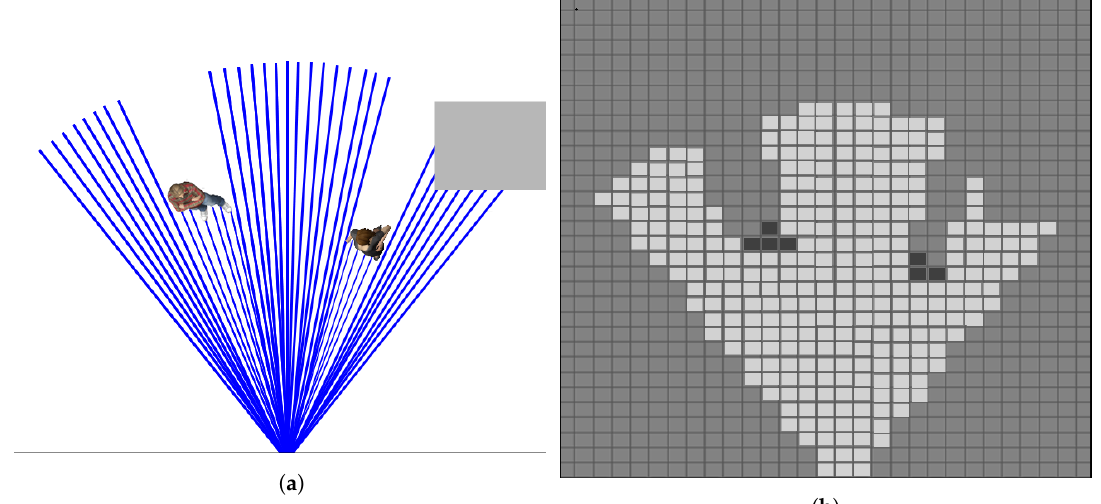
Figure 1. ( a ) Shows the top-view of the scene containing people and an object scanned by an RGB-D camera. ( b ) Shows the obtained occupancy grid of the scene wherein the higher the probability, the darker the cell is, and vice